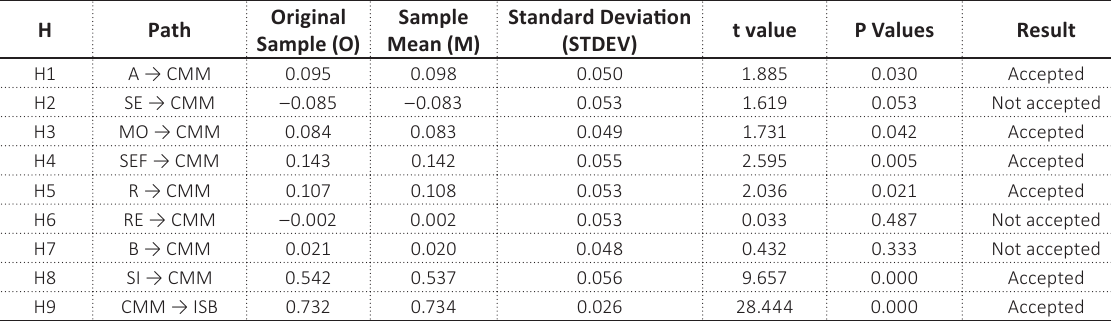
Table 5. List of hypotheses and relative